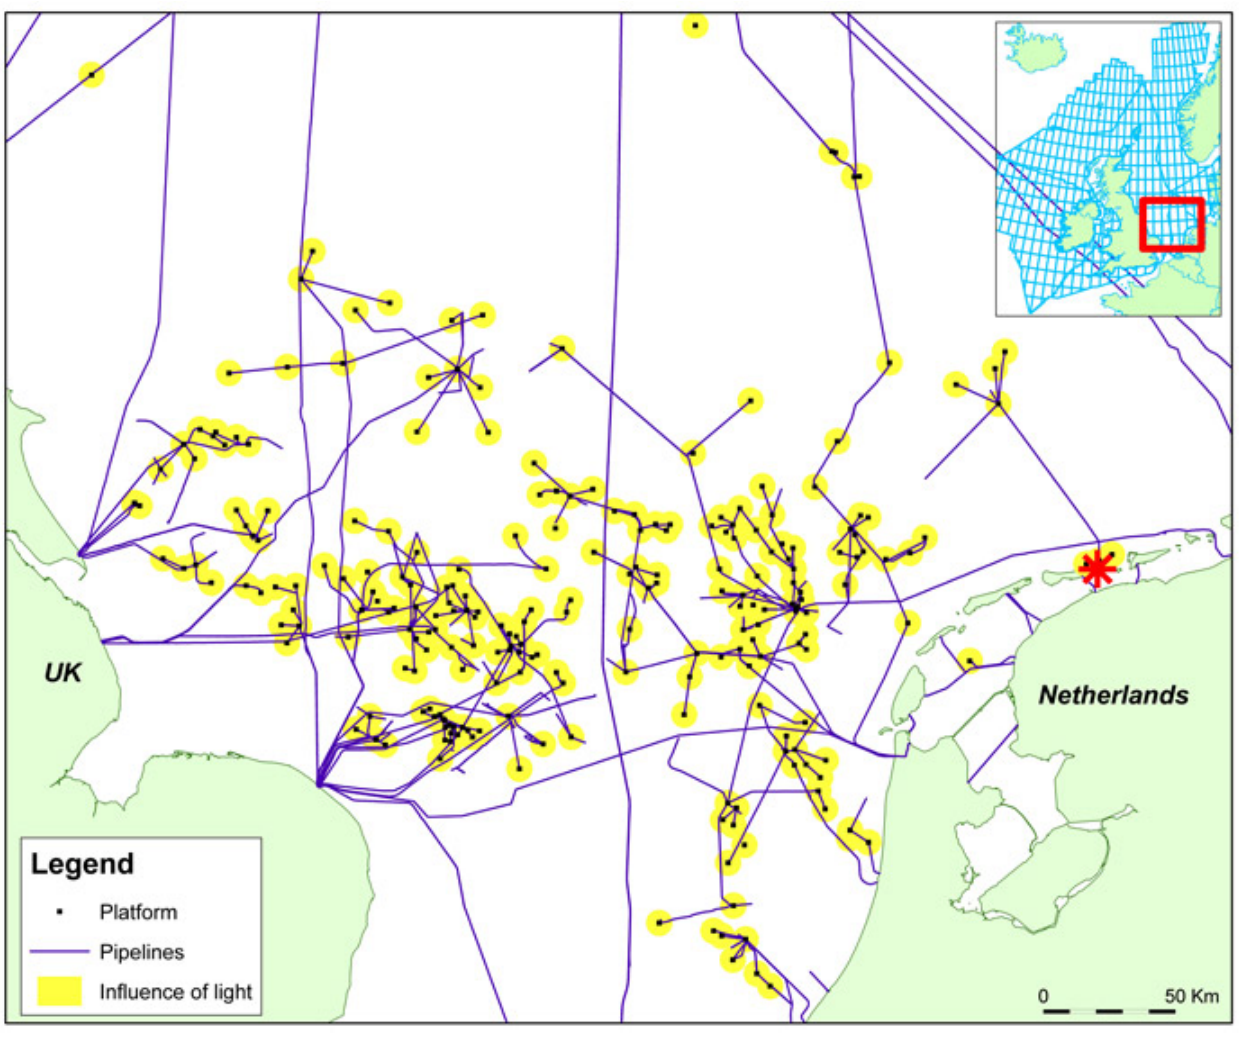
Fig. 1. Map of the southern section of the North Sea with existing production platforms in 2007. For each production platform, the potential impact zone of 5 km is indicated in yellow. The inset indicates where this area is located in the southern part of the North Sea. The red star indicates our study